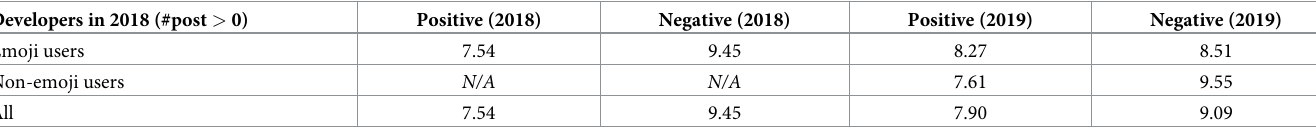
Table 3. Positive and negative emotions expressed via emojis in 2018 and 2019. In general, the population becomes more positive and less negative in 2019. Those who used any emoji in 2018 are more positive ( p < 0.001, Welch two-sample t-test) and less negative ( p < 0.001, Welch two-sample t-test) in 2019 than those who didn’t use an emoji in